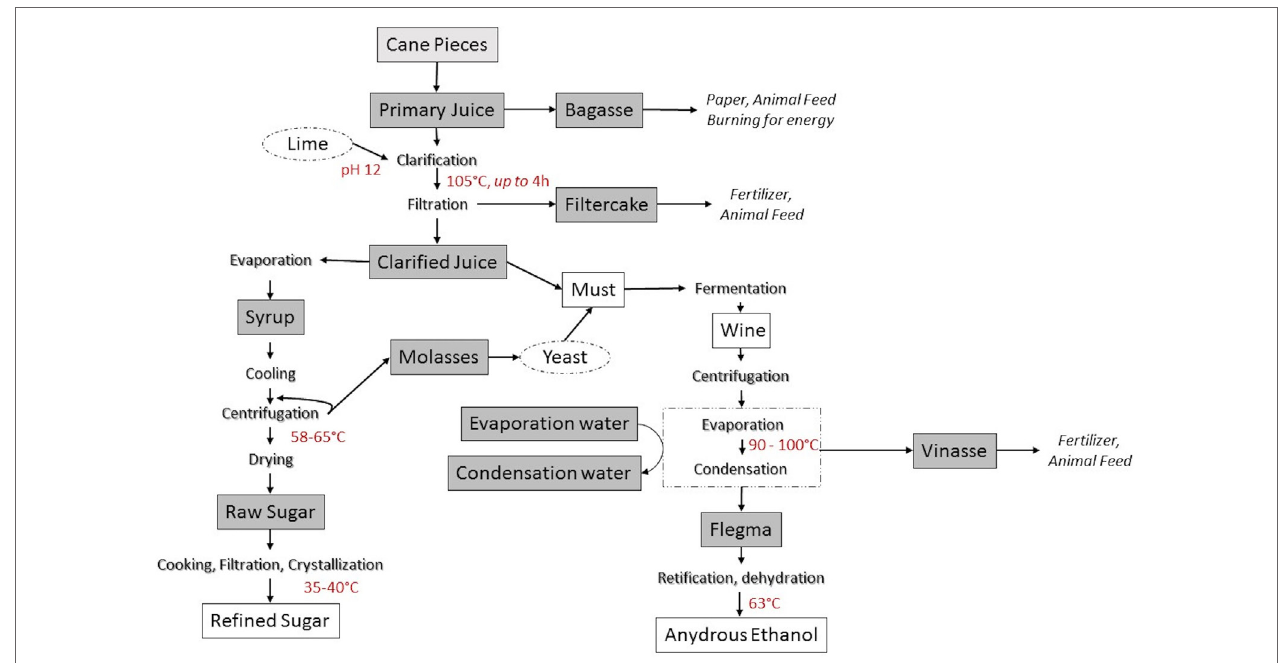
FigUre 1 | Sugarcane industrial processing and derived food ingredients. Gray boxes indicate sampling points in the process. Lighter gray box (cane pieces) indicates the sampling of